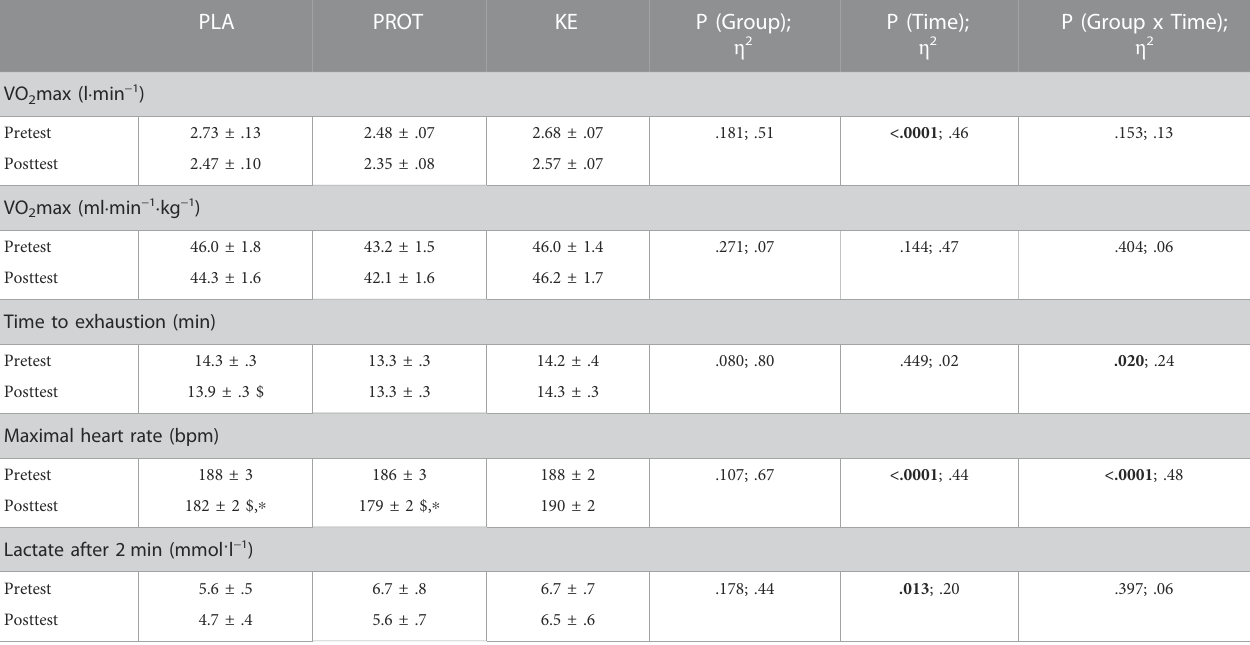
TABLE 4 Effect of increased protein intake and exogenous ketosis on performance in the VO 2 max test during a hypocaloric diet. Data are mean ± SEM. Subjects were involved in a 4-week hypocaloric diet (30% energy restriction, .8 – 1.0 g protein · kg BW − 1 · day − 1 ) combined with placebo (PLA: n = 11), an increased amount of dietary protein (PROT: n = 10) or a ketone ester (KE: n = 11). An incremental VO 2 max test was performed before (pretest) and at the end (posttest) of the caloric restriction period. Signi fi cant main effects are shown in bold.In case of signi fi cant interaction, post hoc differences are shown as $: signi fi cantly different from the corresponding value at pretest ( p < .05), *: signi fi cantly different from KE ( p < .05). Effect sizes are reported as eta squared ( η 2